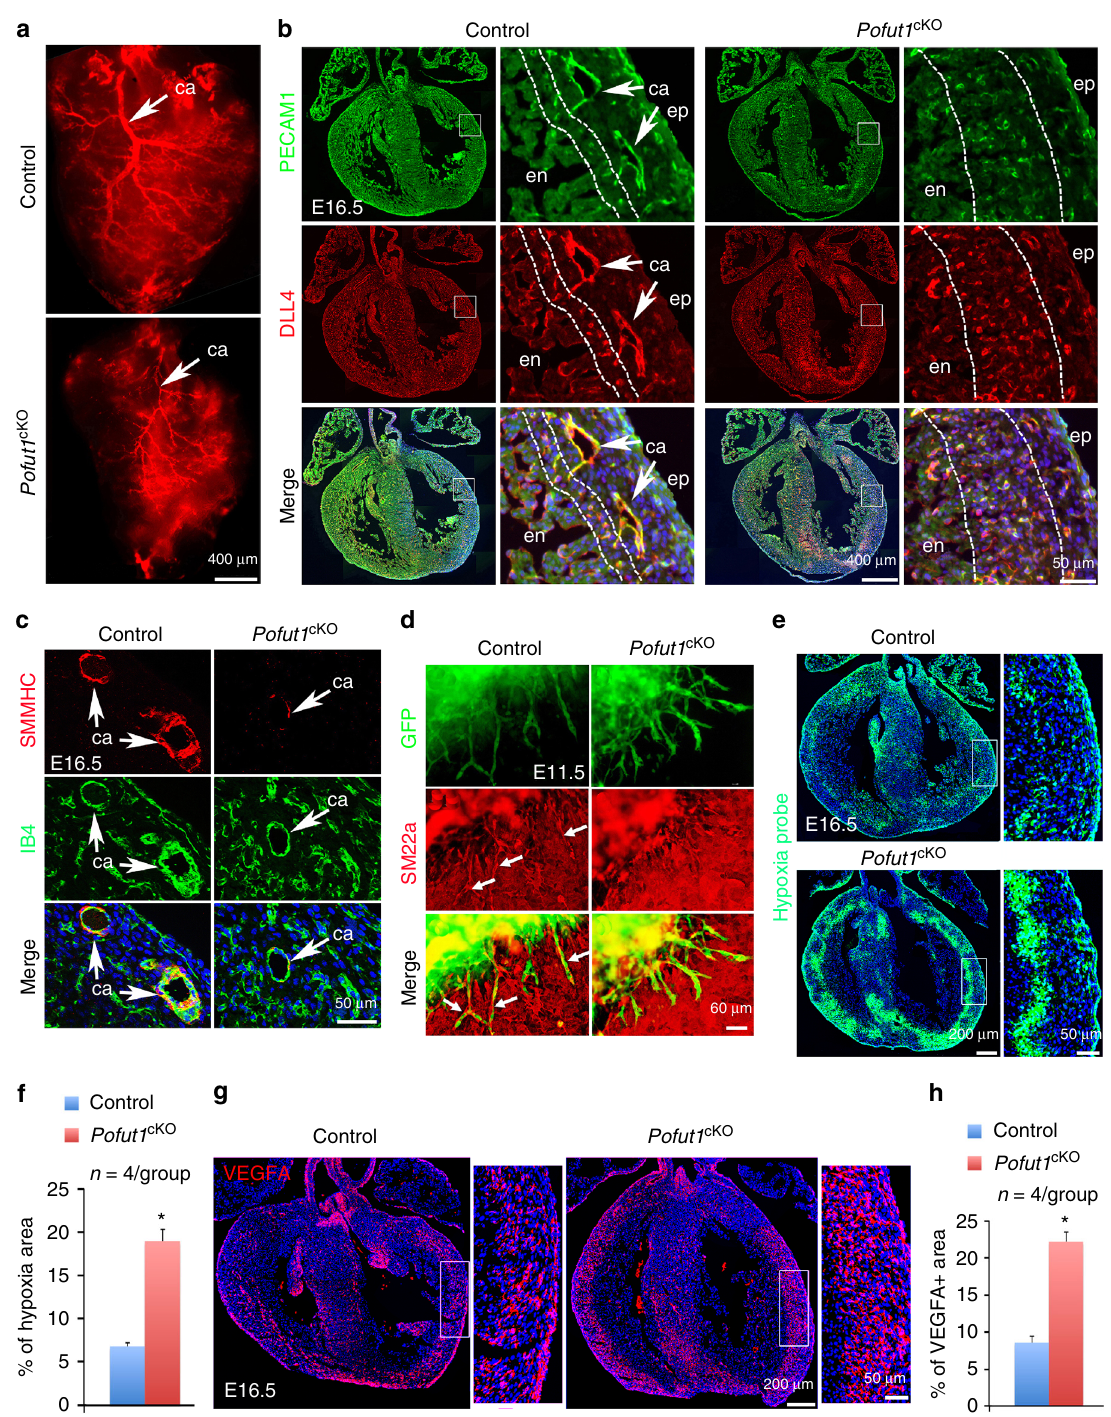
Fig. 2 POFUT1 is required for coronary artery formation. a Coronary arteriography using red fl uorescent dye showing underdeveloped coronary arteries (ca, arrow ) in a E16.5 Pofut1 cKO heart. ( b ) Co-immunostaining for PECAM1 and DLL4 on E16.5 of control and Pofut1 cKO heart sections. High magni fi cation images on right showing boxed regions in the individual left ventricles with smaller main arteries ( arrows ) and expansion of arterial plexus in the